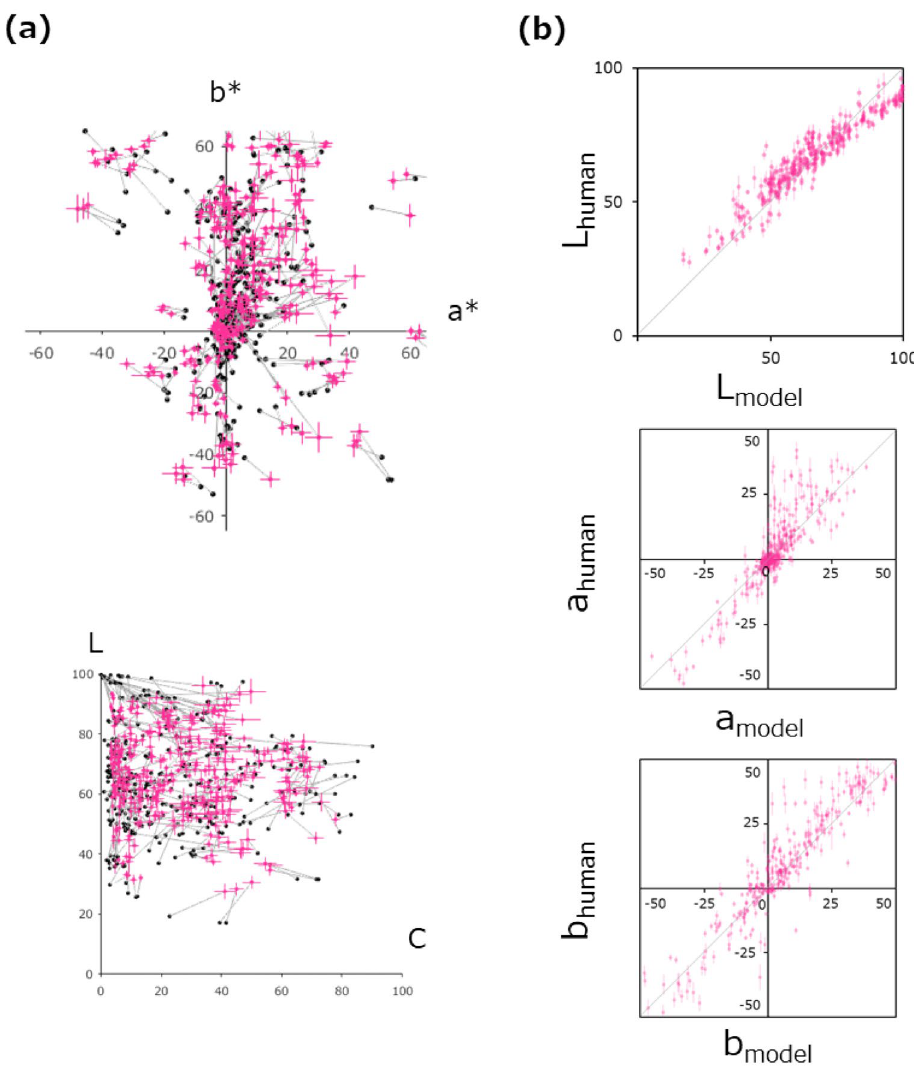
Figure 9. ( a ) Matching data predicted by the model and observed data. Results for all 360 natural and synthetic images. A red circle represents the average of the matched representative color, and the black dot connected to it by a line represents the color predicted by the model. The upper and lower panels show the results in the a * –b * and L-chroma planes, respectively. ( b ) The relationship between the human data and model data. The horizontal axis shows the model predictions, and the vertical axis shows the human data. The top, middle, and bottom panels show the results for the L, a * , and b * axes, respectively. Error bars represent the ± 1 s.e.m. across